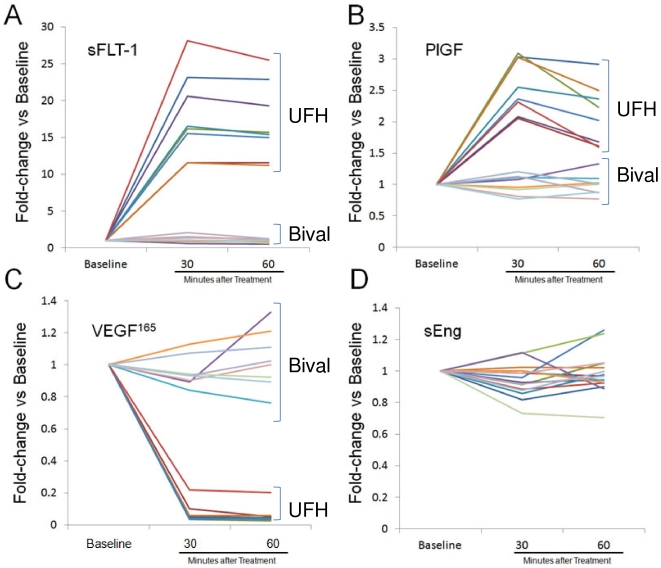
Effects on angiogenic peptides of UFH (dotted lines) and bivalirudin (dashed lines) in human subjects undergoing PCI.sFlt1 (A) and PlGF (B) were significantly increased by UFH but not bivalirudin, VEGF165 (C) was significantly decreased by UFH but not bivalirudin, and sEng (D) was unchanged with both UFH and bivalirudin.